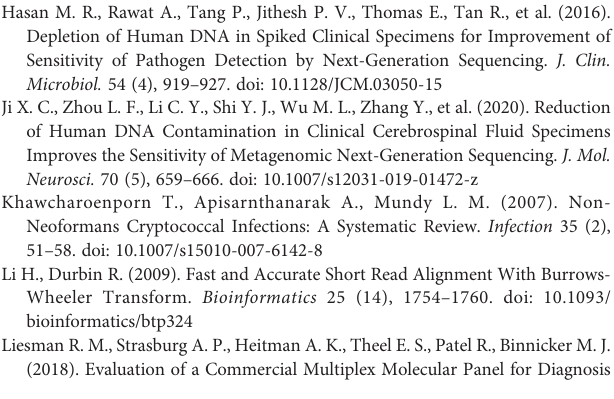
mNGS, metagenomic next-generation sequencing; RPM, reads per